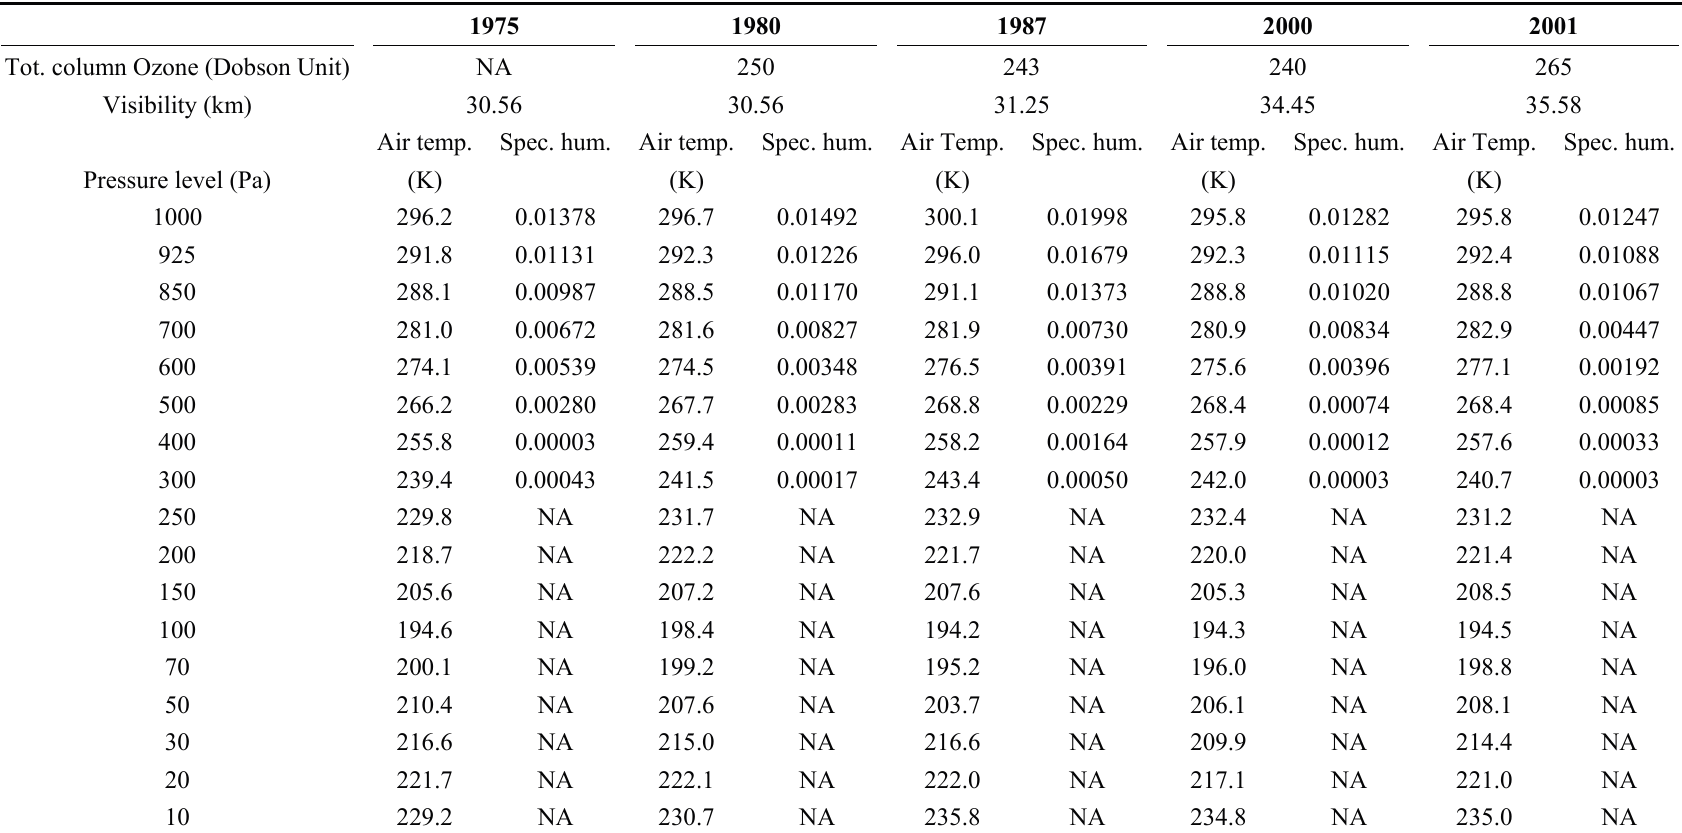
Table 3. Atmospheric composition at time of image acquisition. Missing values (NA) were filled with the tropical standard atmosphere values from the Second Simulation of the Satellite Signal in the Solar Spectrum radiative transfer code (6S code). Tot. column Ozone (Dobson